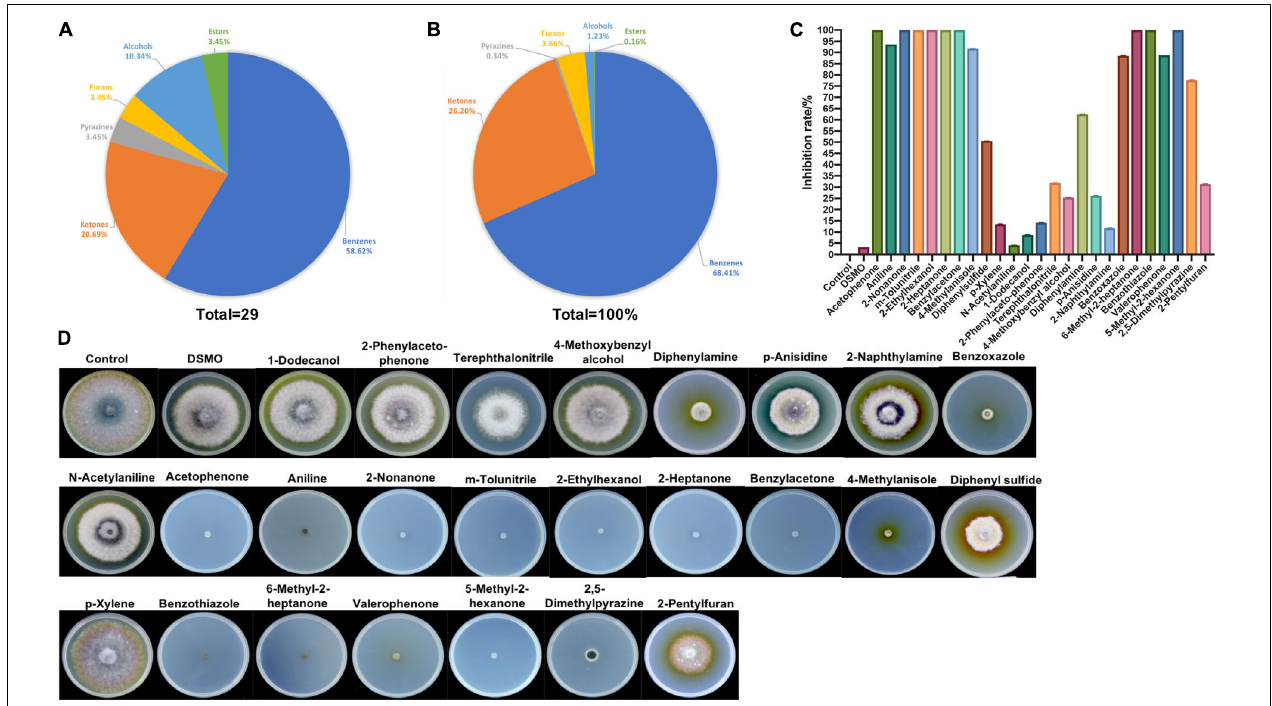
FIGURE 4 | Identification of ZD01 volatiles and inhibition effects of selected VOCs on A. solani . (A) Classification of VOCs produced by ZD01. (B) Peak area of six identified classes of VOCs from ZD01. (C) Inhibition rate of 25 identified VOCs against A. solani . (D) Colony diameter of A. solani co-cultured with 25 identified VOCs. Control represents A. solani without treatment of pure identified